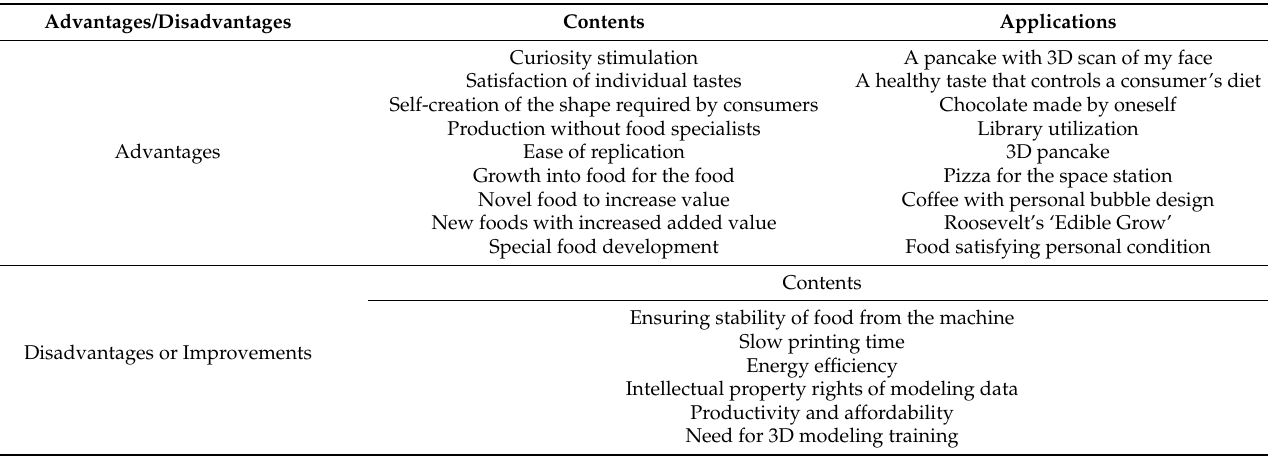
Table 6. Advantages and disadvantages of 3D food printing in food